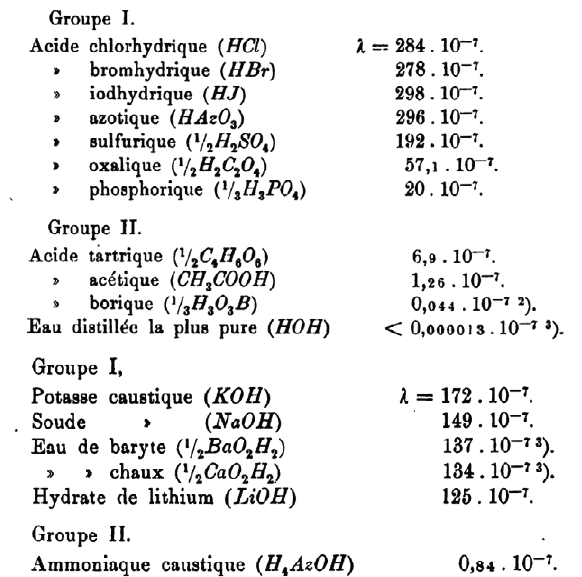
Table 1. Molecular conductivities, λ, of strong (Group I) and weak (Group II) acids and bases. Concentrations of electrolyte solutions: 1 g equiv. solute per liter solution. The conductivities were taken or calculated from ref. [21] , that of distilled water see Première partie, § 8. [6] The table is reproduced from Arrhenius´ dissertation, Seconde partie, [7] p. 14 and